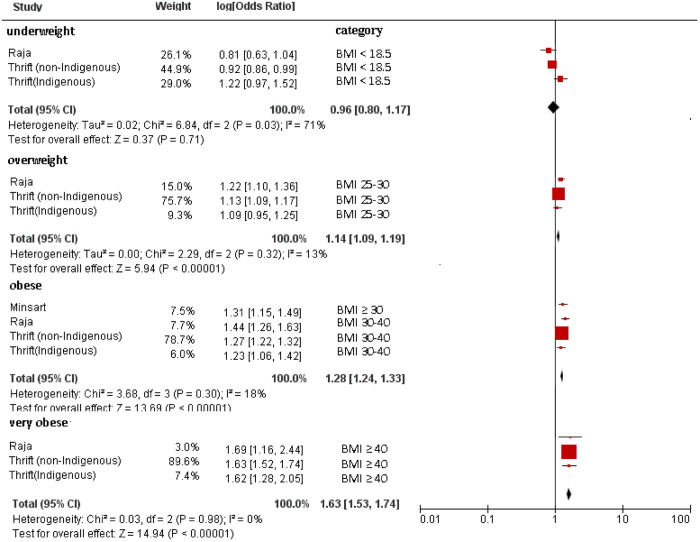
Forest plot of pooled analyses of maternal BMI categories and an Apgar score <7 at 1 minute.Maternal overweight, obesity and very obesity by BMI categories was significantly associated with Apgar score <7. Maternal underweight categories showed nonsignificant trends toward increased an Apgar score <7. Note that obesity group compared with non-obese controls (BMI < 30) in the Minsart et al. study. In others studies, ORs are for each category as compared with the “normal weight” category (BMI 18–25).